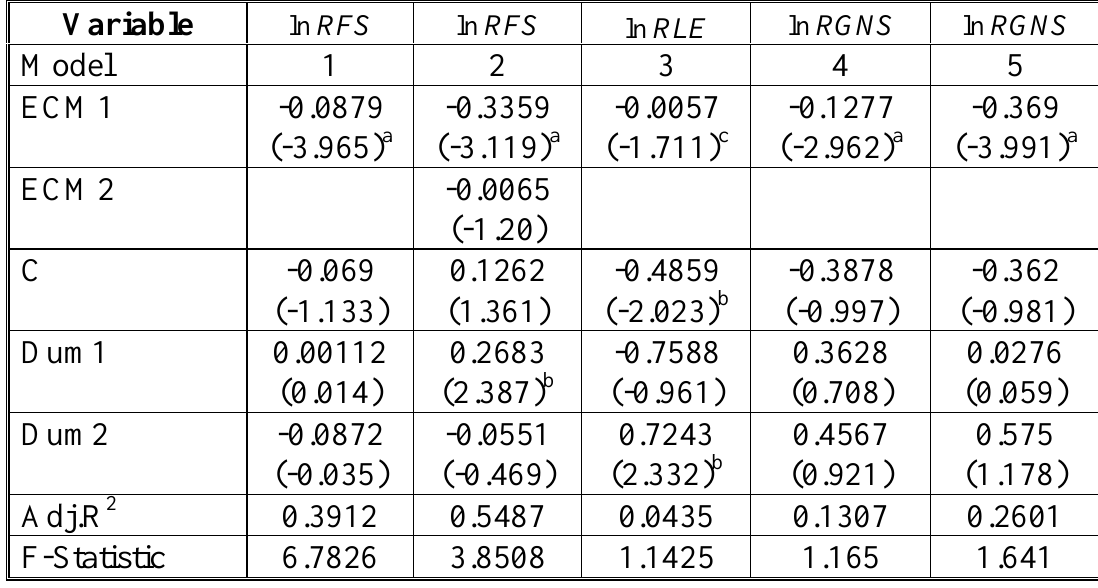
Table 5 Vector error correction model- , RFS ln RLE ln and RGNS ln Variable RFS ln RFS ln RLE ln RGNS